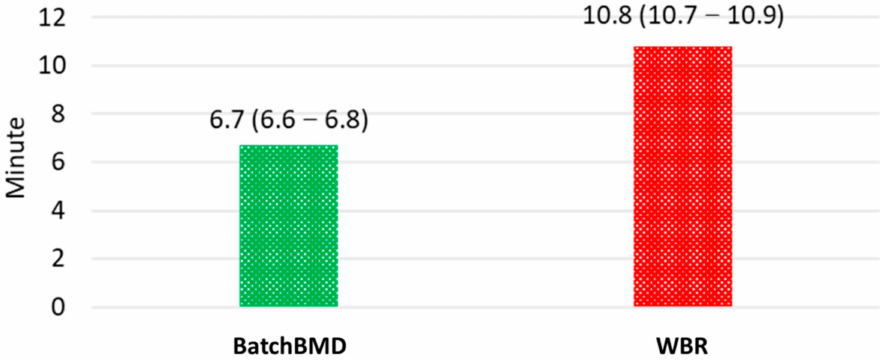
Figure 4. Average (95% confidence interval) reporting time for the two